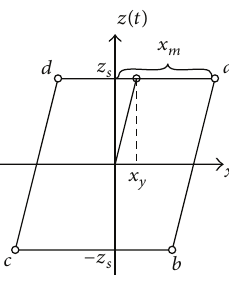
Figure 3: The constitutive relation of the damping force 𝑧(𝑡) . The damping force 𝑧(𝑡) is a periodic function with the rotation of the rotor, its period is 2𝜋/Ω .